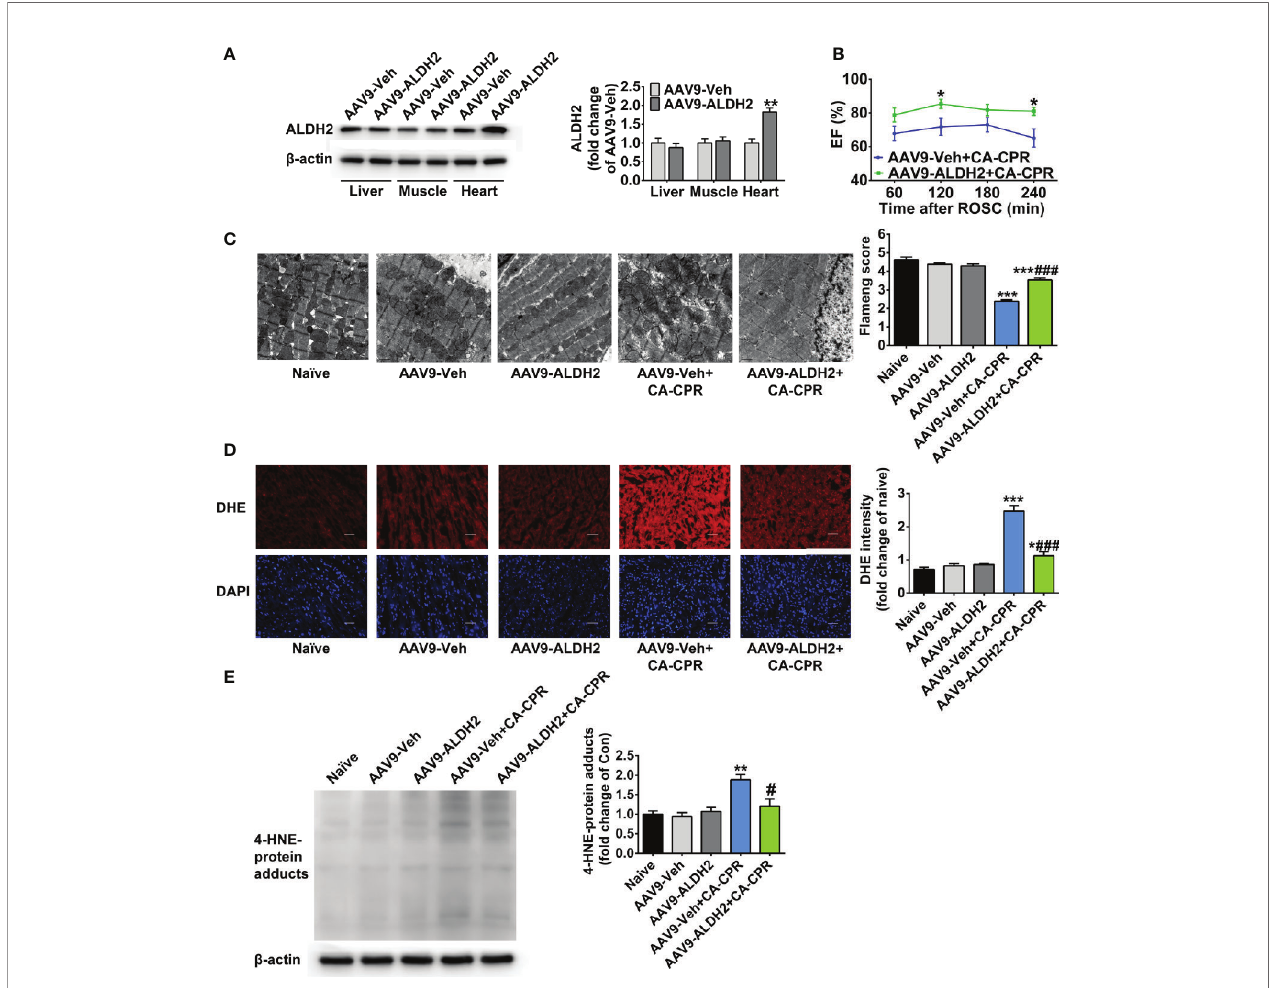
FIGURE 4 | The effect of cardiac overexpression of ALDH2 on post-cardiac arrest myocardial dysfunction and mitochondrial structural damage. (A) Representative immunoblots and quanti fi cation of ALDH2 expression in the liver, skeletal muscle, and heart tissue ( n = 5 animals per group). ** P < 0.01 versus AAV9-Veh group. (B) Left ventricular EF within 4 h after ROSC in AAV9-Veh+CA-CPR and AAV9-ALDH2+CA-CPR group ( n = 7 – 8 animals per group). * P < 0.05 versus AAV9-Veh +CA-CPR group. (C) Representative photographs and quanti fi cation of mitochondrial morphology by TEM examination at 1 h after ROSC ( n = 3 animals per group). Scale bar = 1 m m. *** P < 0.001 versus Naïve group; ### P < 0.001 versus AAV9-Veh+CA-CPR group. (D) Representative photographs of dihydroethidium (DHE) staining at 4 h after ROSC (n = 4 animals per group). Scale bar = 100 m m. * P < 0.05, *** P < 0.001 versus Naïve group; ### P < 0.001 versus AAV9-Veh+CA-CPR group. (E) Representative immunoblots and quanti fi cation of 4-HNE-protein adducts at 4 h after ROSC ( n = 4 animals per group). Myocardial function between groups was compared by Student ’ s t-test and time-based measurements within each group were compared by repeated-measures ANOVA. The mitochondrial morphology, DHE intensity, and 4-HNE-protein adducts between groups were compared by ANOVA with Tukey ’ s post hoc test. Data are presented as mean ± SEM. ** P < 0.01 versus naïve group; # P < 0.05 versus AAV9-Veh+CA-CPR